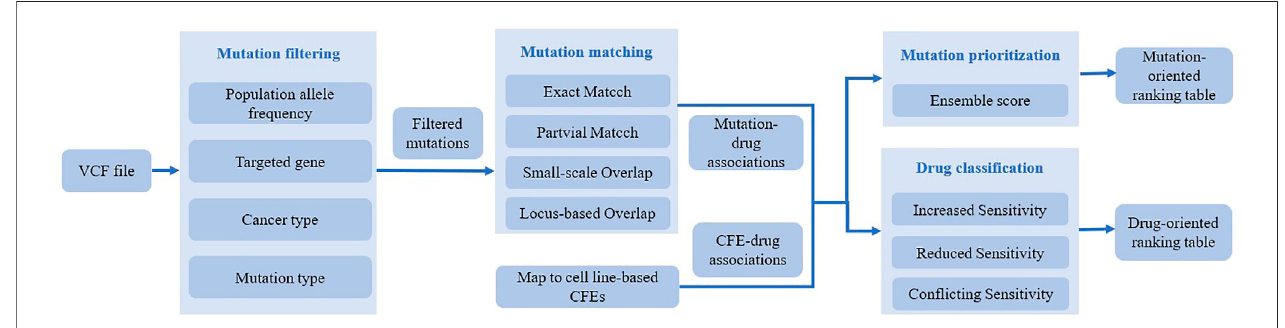
FIGURE 4 | Flowchart of representative platform for drug resistance mutations prediction.